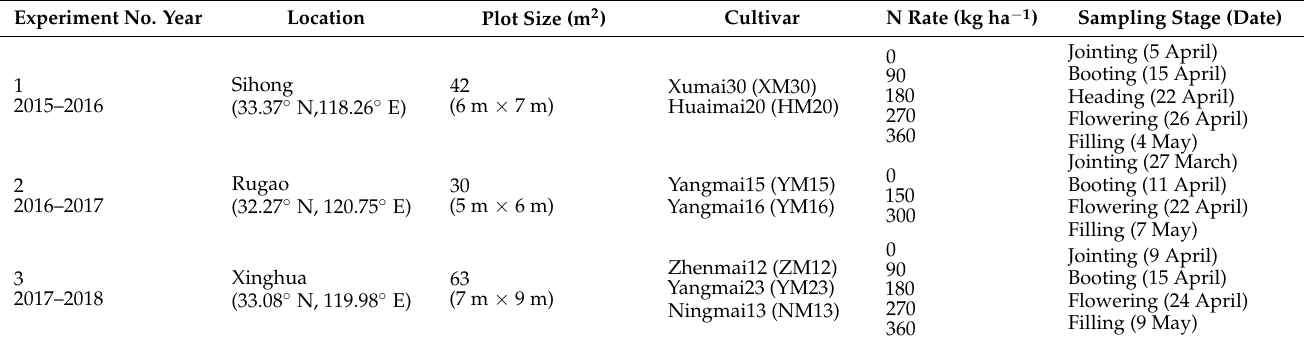
Figure 1. Three study sites in the Jiangsu province of China. Table 1. Basic information about the three field experiments.